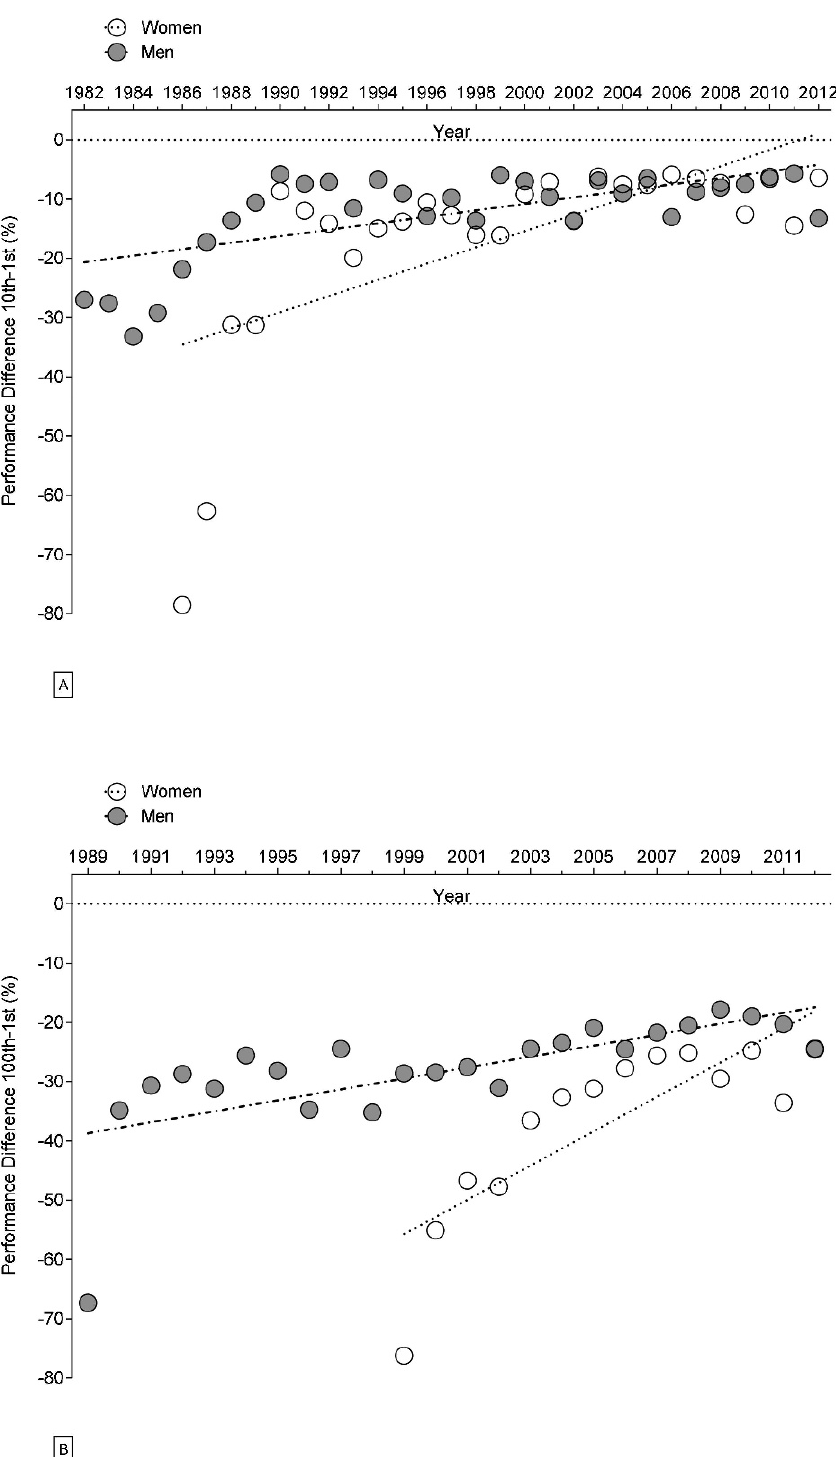
Figure 3 - Differences in running speed between the 1 st and the 10 th place finishers (Panel A) and between the 1 st and the 100 th place finishers (Panel B) expressed as percentages of the winning times for both women and